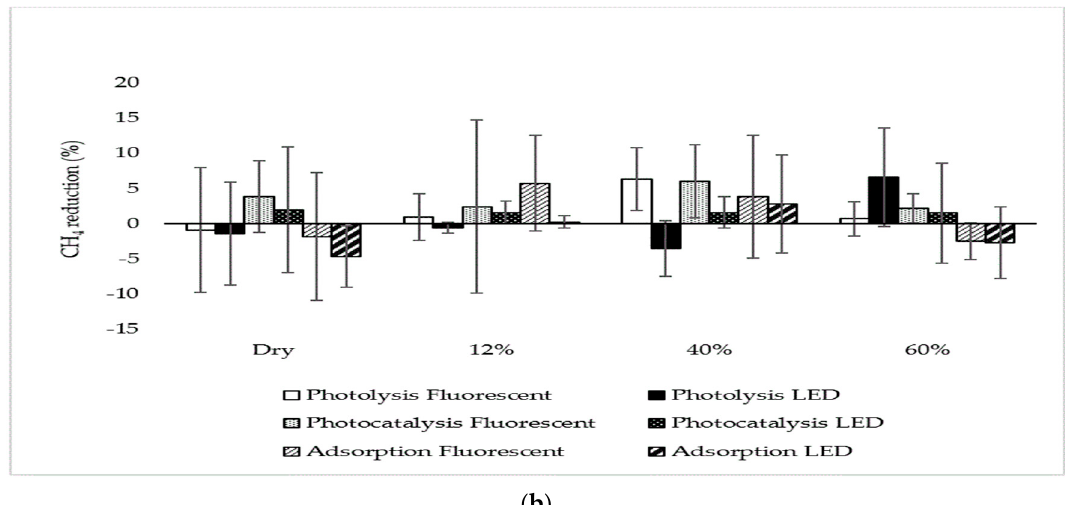
Figure 8. Comparison of CH 4 mitigation under relative humidity. ( a ) % reduction at a treatment time of 40 s; ( b ) % reduction at a treatment time of 200 s. Error bars signify ± standard deviation.